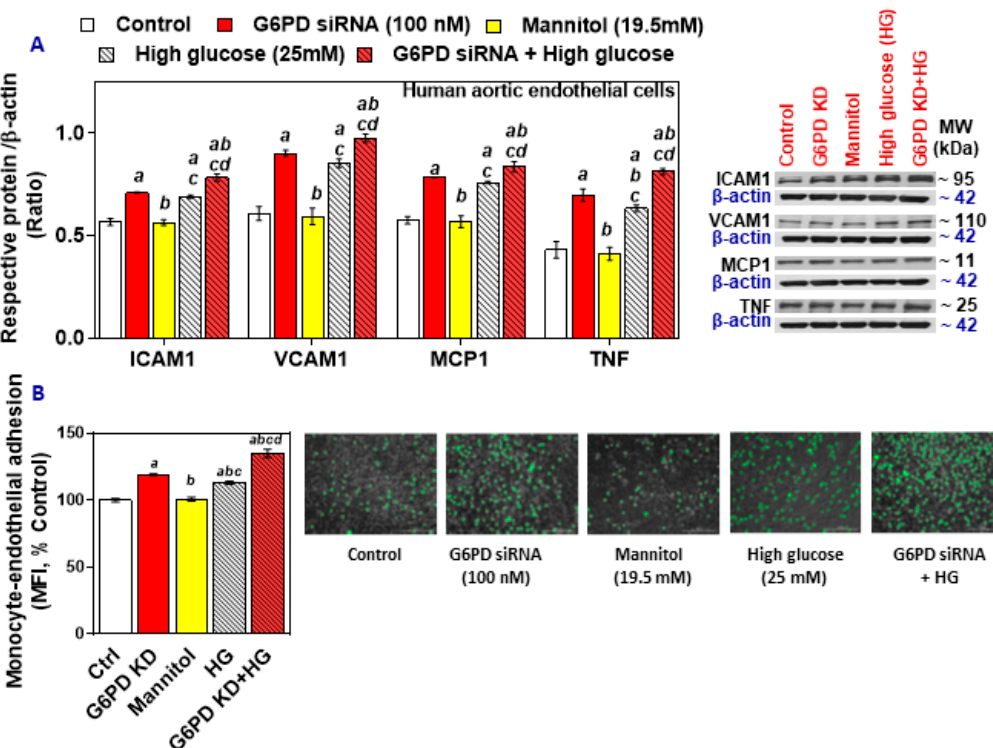
Figure 2. The effect of treatment with high glucose on cell adhesion molecules (ICAM-1, VCAM-1), MCP-1, and TNF in G6PD-normal and G6PD-deficient HAEC and monocyte-endothelial cell adhesion. ( A ) Representative Western blot analysis (ICAM-1, VCAM-1, MCP-1, and TNF) performed on total protein. The left panel represents the semi-quantitative analysis of the ratio of protein abundance to β -actin. ( B ) Phase-contrast images of HAEC and SC monocytic cells (scale bar: 200 µ m). Results are mean ± SEM ( n = 3–6). Significance at p < 0.05: a, compared with control; b, compared with G6PD siRNA; c, compared with mannitol; d, compared with high glucose.